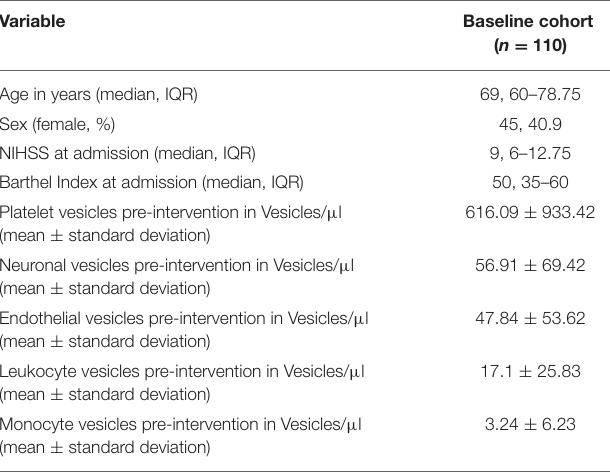
TABLE 2 | Baseline characteristics of the full BAPTISe